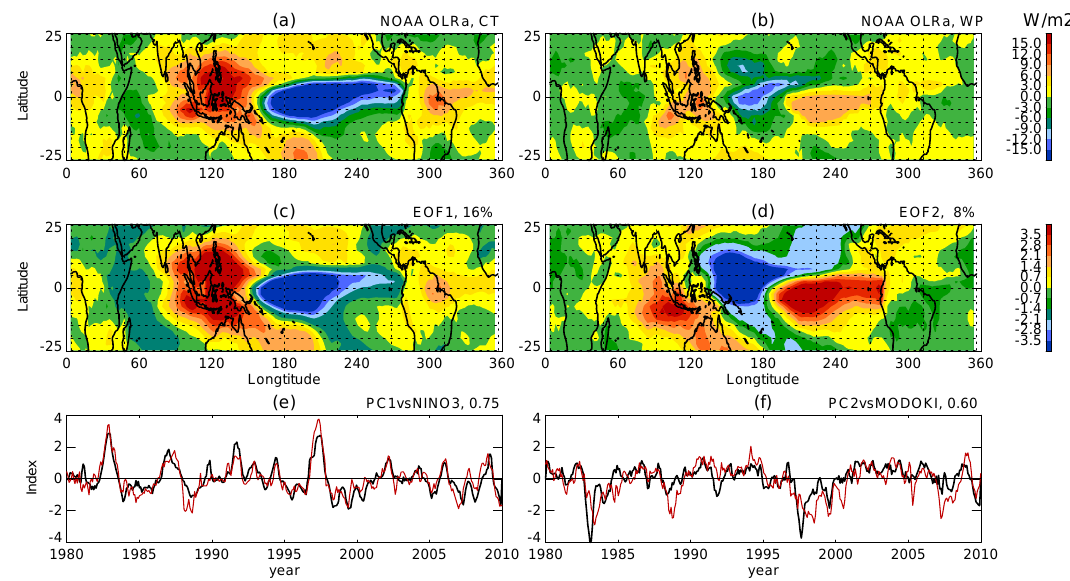
Fig. 2. Composite OLR anomalies for (a) canonical El Ni˜no events, and (b) El Ni˜no Modoki events, based on NOAA data for 1979–2010. Contour interval, ± 3Wm − 2 . (c) and (d) are the leading and second modes of the EOF spatial pattern of OLR anomalies, respectively. Contour interval, ± 0.007. (e) and (f) are the leading and second modes of PC interannual variability, respectively. The red line in (e) is the N3I; the red line in (f) is the EMI. The values at the top right corners of (e) and (f) are correlation coefficients describing the correlations between the